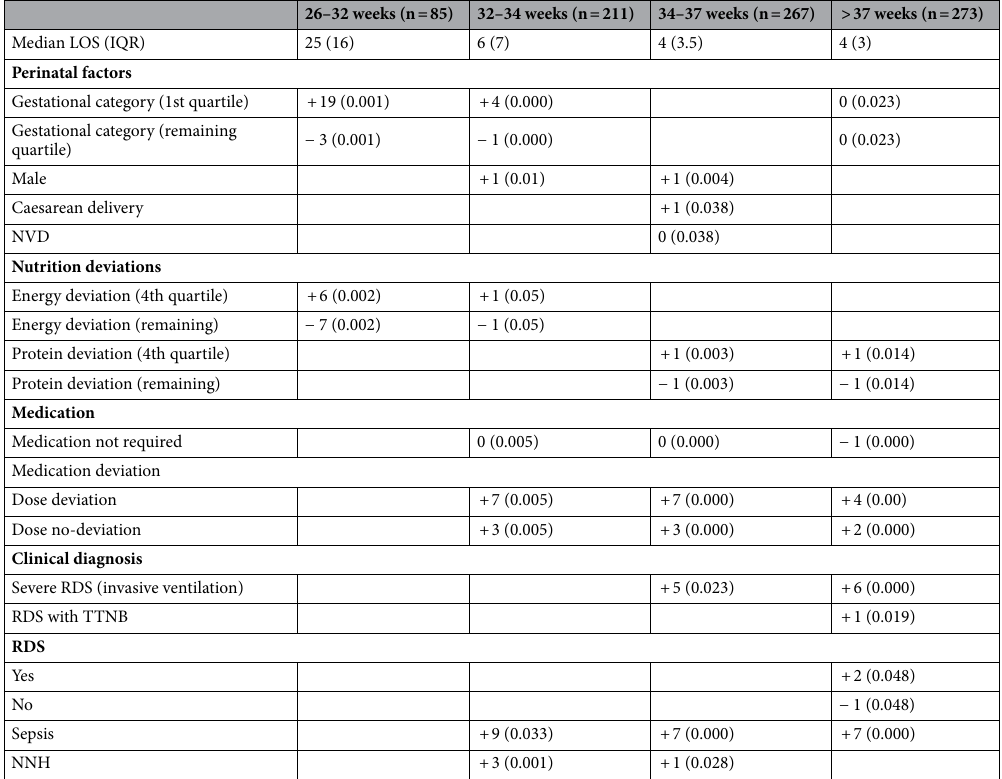
Table 2. Significant independent variables affecting LOS across various categories. All values mentioned as “number of days” obtained after ls means analysis and (p-value). NVD normal vaginal delivery, RDS respiratory distress syndrome, TTNB transient tachypnea of the newborn, NNH neonatal